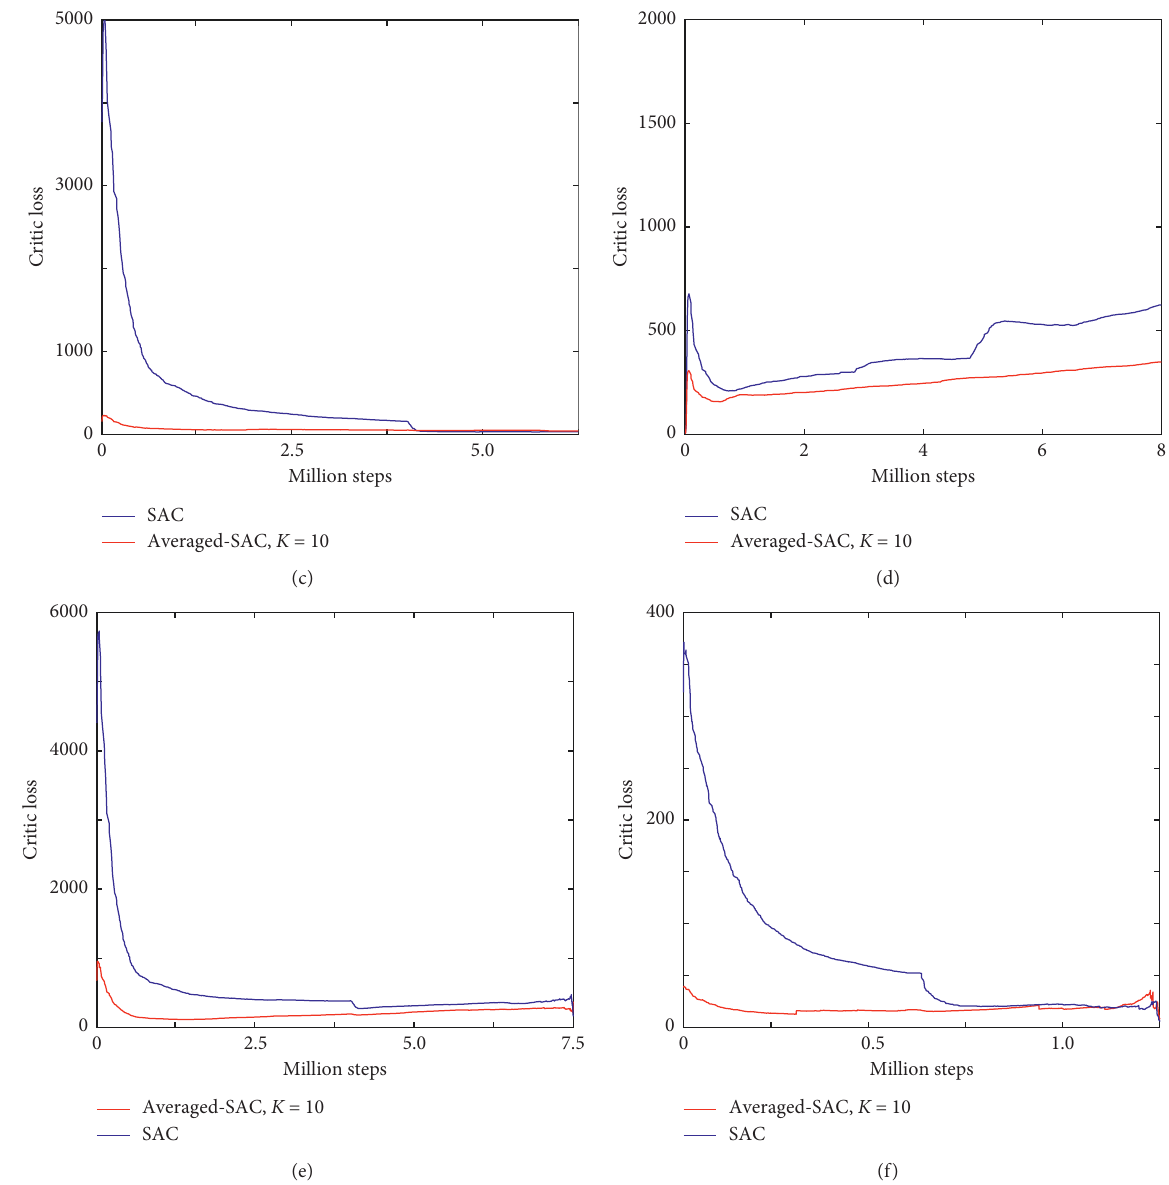
Figure 3: Results of the critic loss of Averaged-SAC and SAC in 6 MuJoCo games. (a) Ant-v2. (b) HalfCheetah-v2. (c) Hopper-v2. (d) Humanoid-v2. (e) Walker2D-v2. (f)